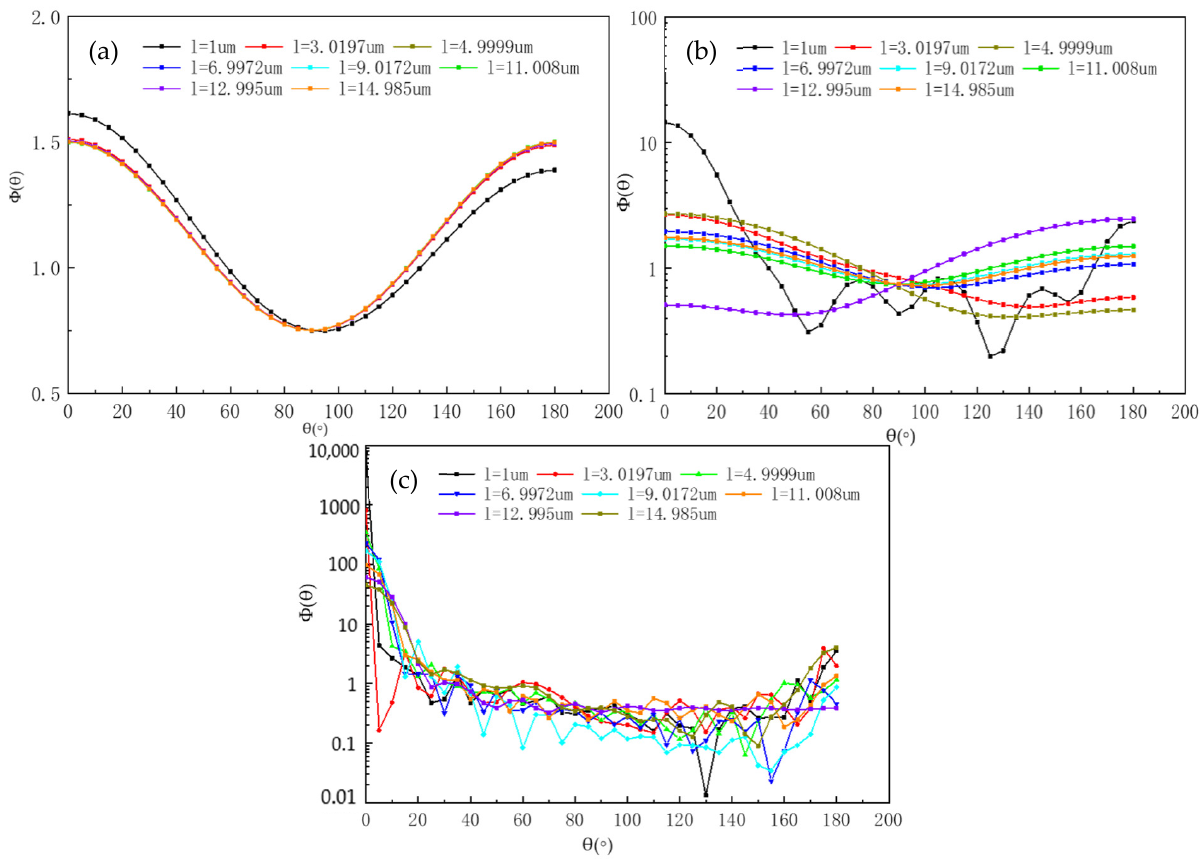
Figure 2. Scattering phase functions of SiC particle changes with different wavelengths: ( a ) d = 0.1; ( b ) d = 1.5; ( c ) d = 38 μ m.